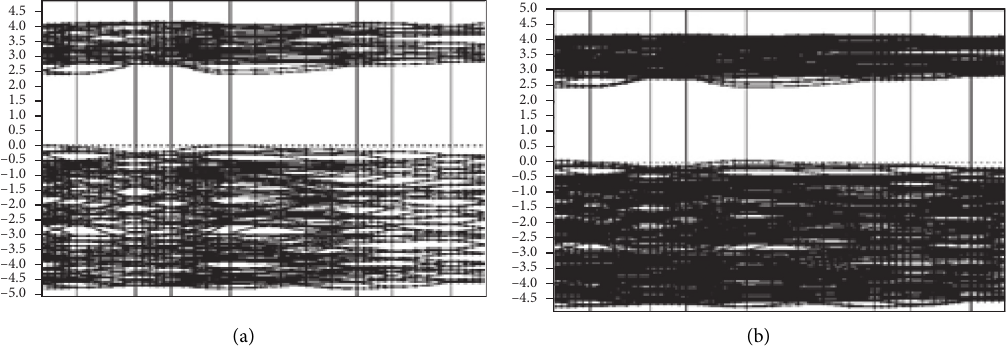
Figure 8: Band structures for (a) brookite and (b) Mg-doped brookite.